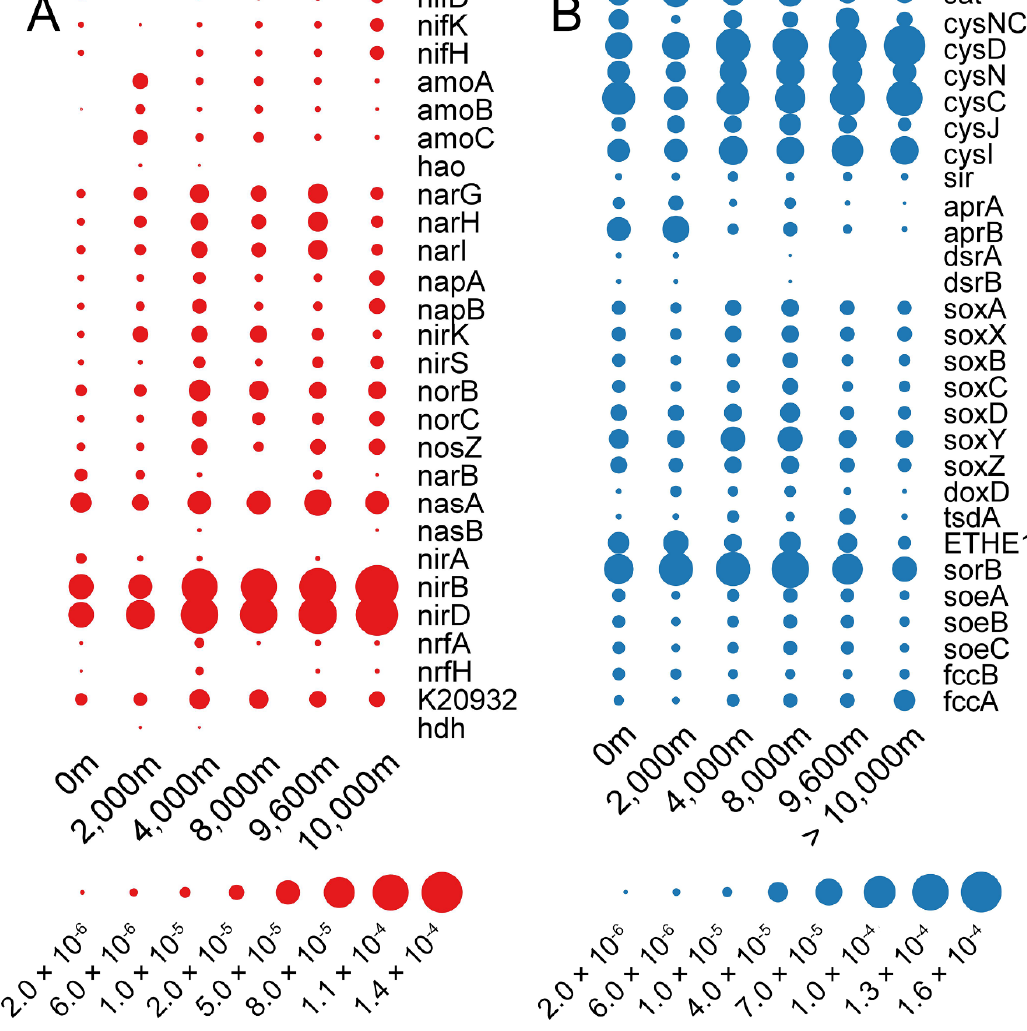
Figure 5. Relative abundance of genes involved in the microbial nitrogen ( A ) and sulfur ( B ) cycle in the six depths examined in the Mariana Trench. NifDKH , nitrogenase molybdenum-iron protein; amoABC , methane / ammonia monooxygenase; hao , hydroxylamine dehydrogenase; narGHI , nitrate reductase; napAB , nitrate reductase; nirKS , nitrite reductase; norBC , nitric oxide reductase; nosZ , nitrous oxide reductase; narB , ferredoxin nitrate reductase; nasAB , assimilatory nitrate reductase; nirA , ferredoxin ‐ nitrite reductase; nirB , nitrite reductase (NADH) large subunit; nirD , nitrite reductase (NADH) small subunit; nrfA , nitrite reductase (cytochrome c ‐ 552); nrfH , cytochrome c nitrite reductase small subunit; K20932, hydrazine synthase subunit; hdh, hydrazine dehydrogenase. sat , sulfate adenylyltransferase; cysNC , bifunctional enzyme CysN/CysC; cysD , sulfate adenylyltransferase subunit 2; cysN , sulfate adenylyltransferase subunit 1; cysJ , sulfite reductase (NADPH) flavoprotein alpha ‐ component; cysI , sulfite reductase (NADPH) hemoprotein beta ‐ component; sir, sulfite reductase (ferredoxin); aprAB , adenylylsulfate reductase; dsrAB , dissimilatory sulfite reductase; soxABCDXYZ , thiosulfate oxidation by SOX complex; doxD , thiosulfate dehydrogenase (quinone) large subunit; tsdA , thiosulfate dehydrogenase; ETHE1, sulfur dioxygenase; sorB , sulfite dehydrogenase; soeABC , sulfite dehydrogenase; fccAB , sulfide dehydrogenase.